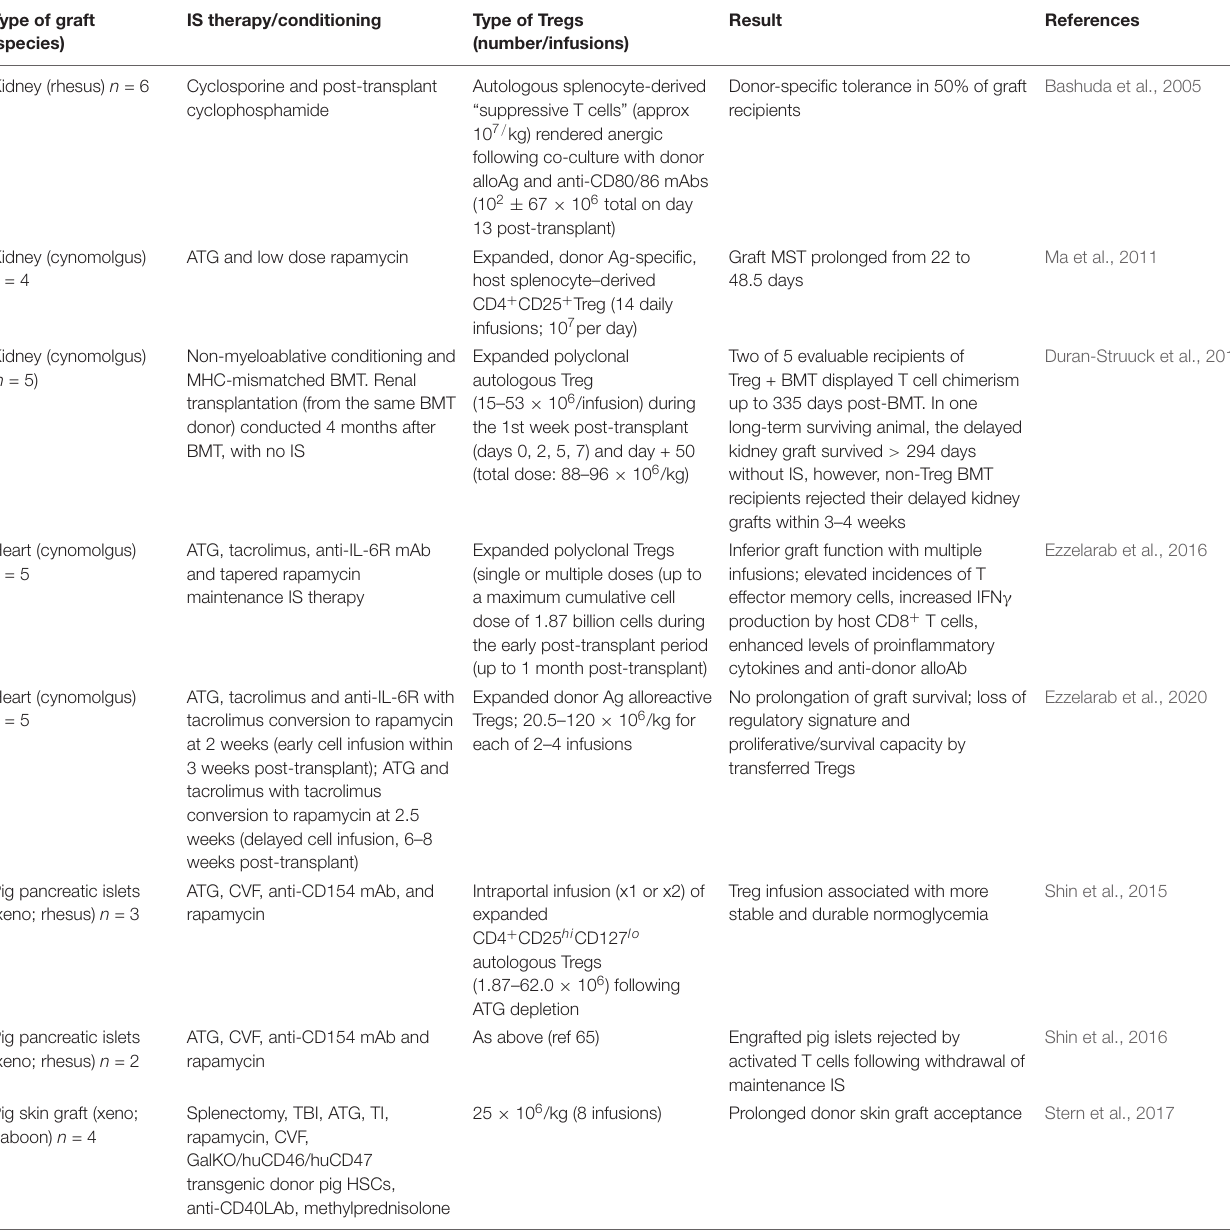
TABLE 3 | Assessment of adoptive Treg therapy in NHP transplant